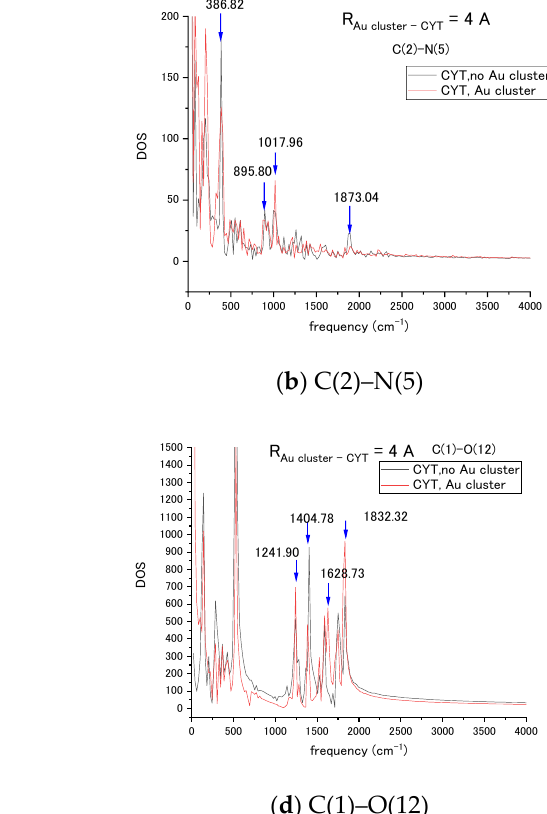
Figure 6. ( a ) System of Au 20 nanoparticle and cytosine nucleotide vs. graphene sheet in initial Au 20 NP orientation where interaction is localized primarily within the tip atom of the Au 20 pyramid; ( b ) rotated NP with the upper plane of the pyramid parallel to the graphene ( x,y ) plane and inter- action with the edge atoms of the Au 20 pyramid enhanced; ( c ) interaction direction of nucleotide with NP changes during nucleotide conformation and alignment at the vibration time. Calcula- tions were first carried out with the initial v com = 0 in x,y,z directions for cytosine and NP.